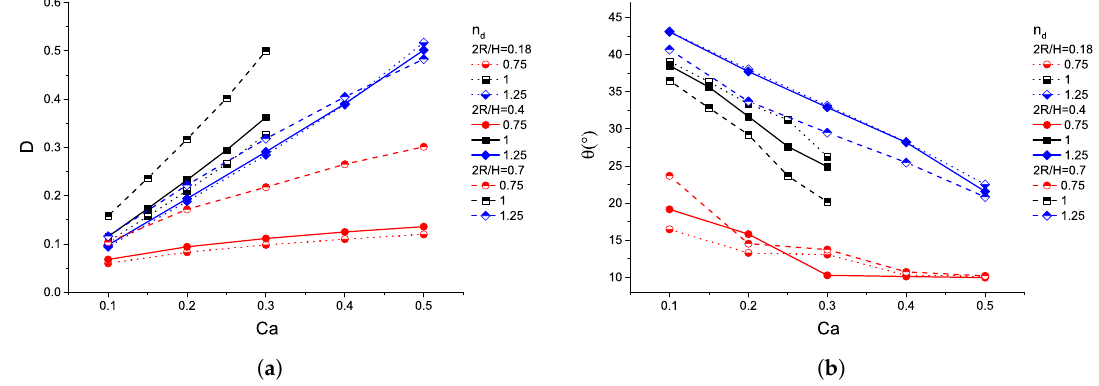
Figure 6. ( a ) droplet deformation and ( b ) orientation angle as a function of the capillary number, Ca, for exponents n d = 0.75, 1, 1.25, in various confinement ratios, 2 R / H